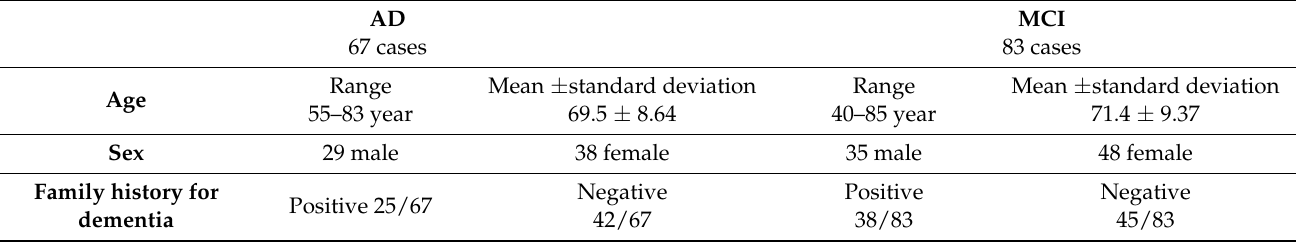
Table 1. Demographic, clinical, Mini Mental State Examination (MMSE) and Magnetic Resonance Imaging (MRI) data of Alzheimer Disease (AD) and Mild Cognitive Impairment (MCI)